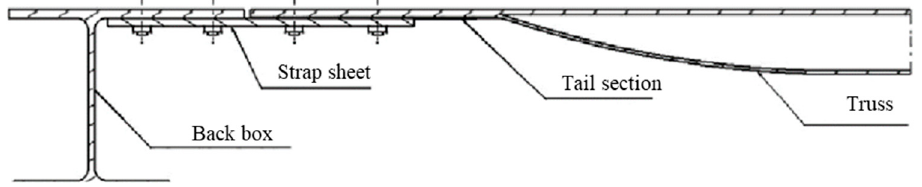
Figure 1. The tail end of the fuselage and the rear section of the strap sheet connection schematic.